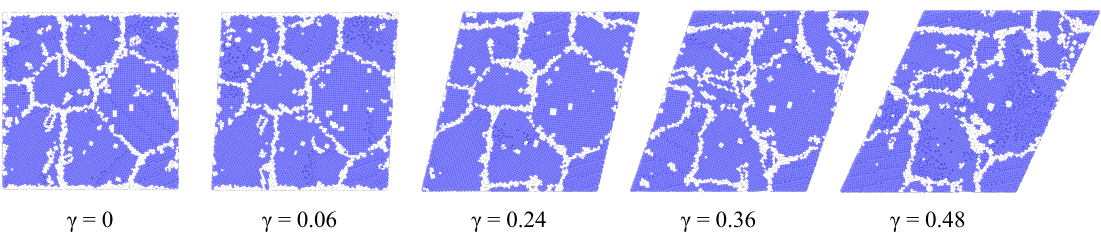
Figure 7. Snapshots of the MD simulation model during shearing test.